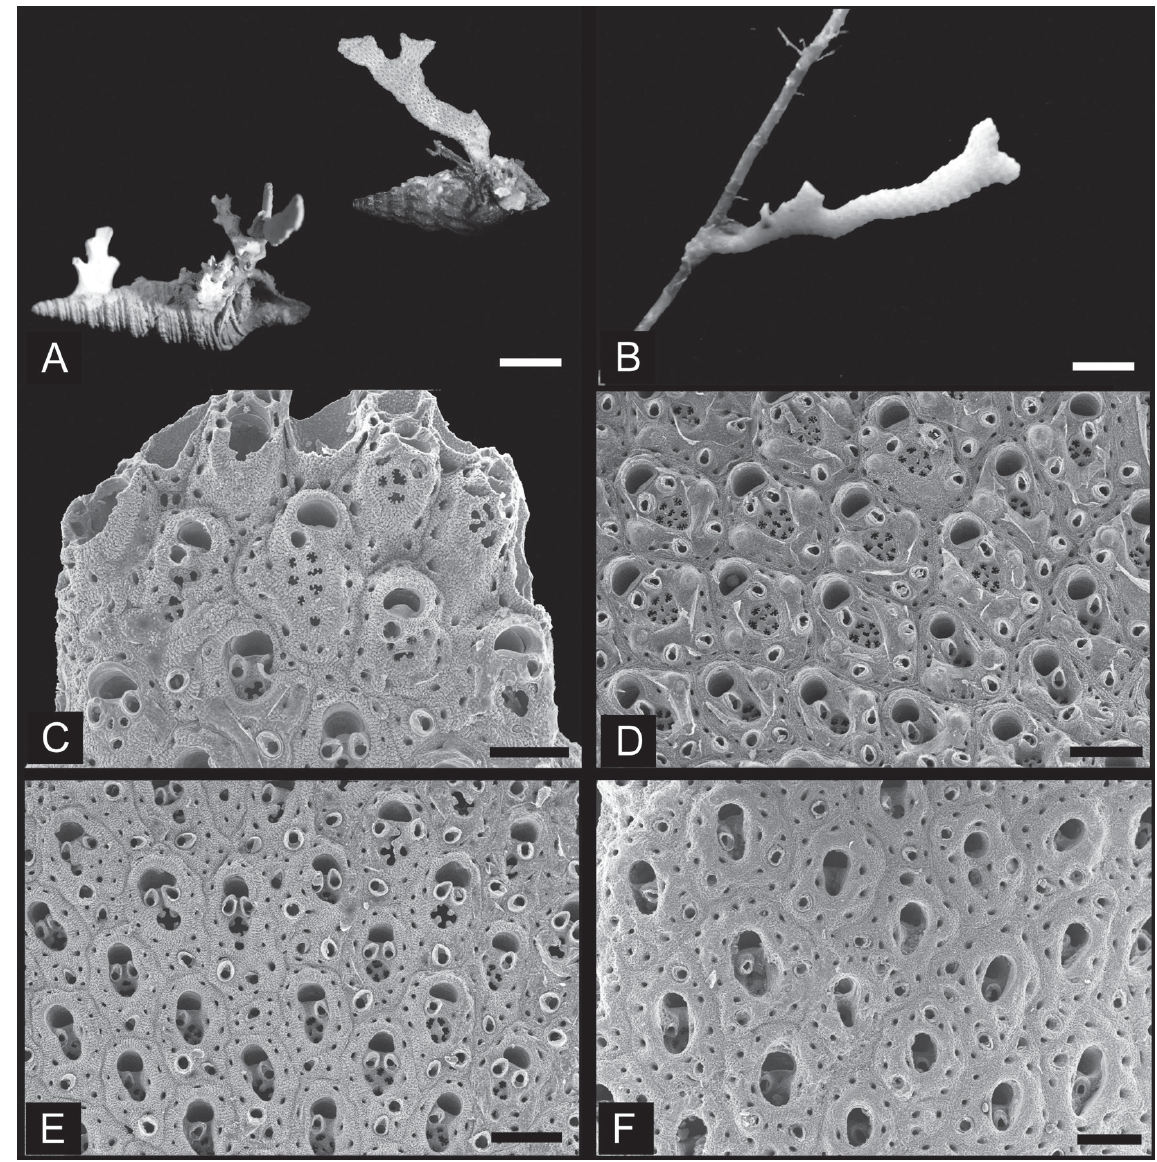
Fig. 11. Adeonellopsis pentapora Canu & Bassler, 1929. A . Left, colony in Döderlein Collection (MZs 2-1); right, colony collected by NsMT (NsMT-Tes22). B . Colony on hydroid stalk, from sagami Bay (NsMT-Tes20). C . Distal end of branch showing young autozooids with multiporous, denticulate spiramen (NsMT-Te761). D . Young autozooids with umbonate processes on frontal shield (NsMT- Te764). E . Mature autozooids with small suboral and other frontal avicularia (NsMT-Te761). F . old autozooids, showing deeply immersed spiramen and orifices (NSMT-Te762). A–B = optical photographs; C–F = SEM images. Scale bars: A = 3 mm; B = 2 mm; C–D, F = 200 μm; E = 250